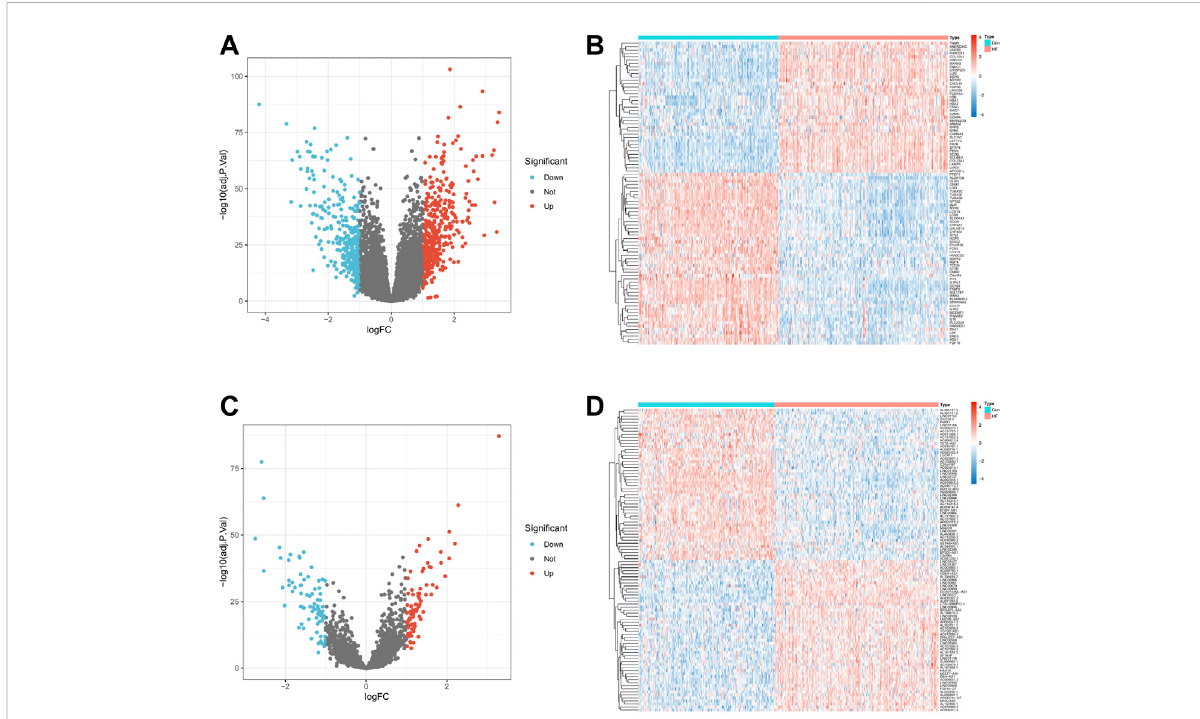
FIGURE 2 Differential expression levels of mRNA and lncRNA in HF. (A,C) . Volcano plot of 727 DEmRNAs and 162 DElncRNAs. Up-regulated genes are indicated in red, and down-regulated genes are indicated in blue. Genes with no signi fi cant change are marked as grey dots. (B,D) . Expression heat map of Top 100 DEmRNA and Top 100 DElncRNA. Red means genes are up-regulated, blue means genes are